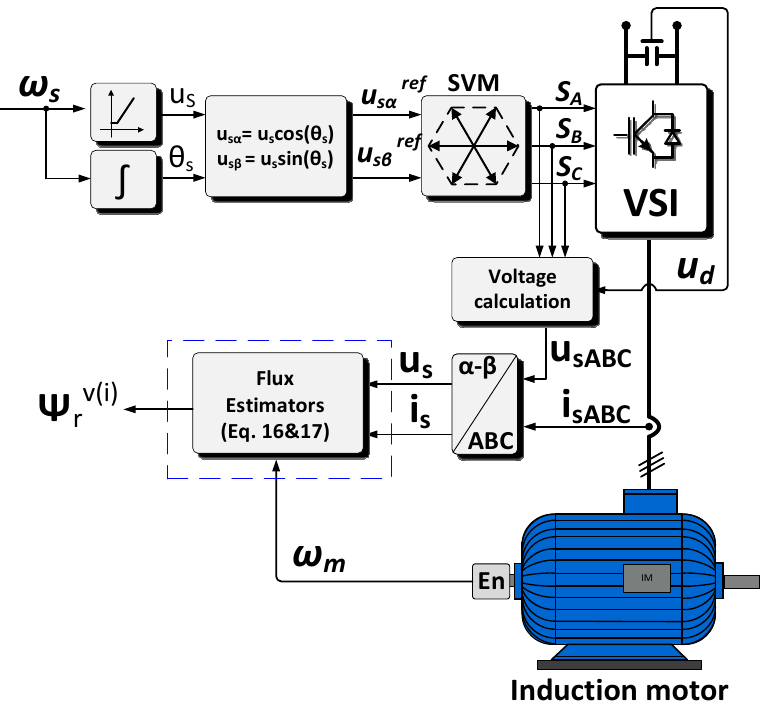
Figure 2. Schematic diagram of v / f control structure (open control loop).